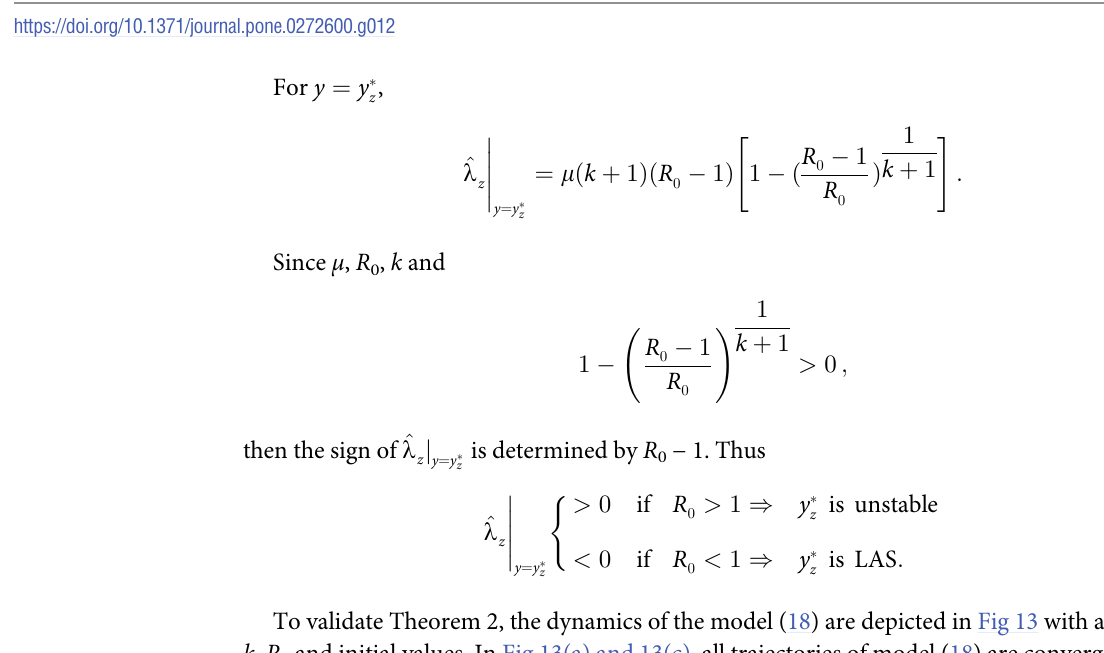
Fig 12. The relationship between F ð y ; k Þ and prevalence, y